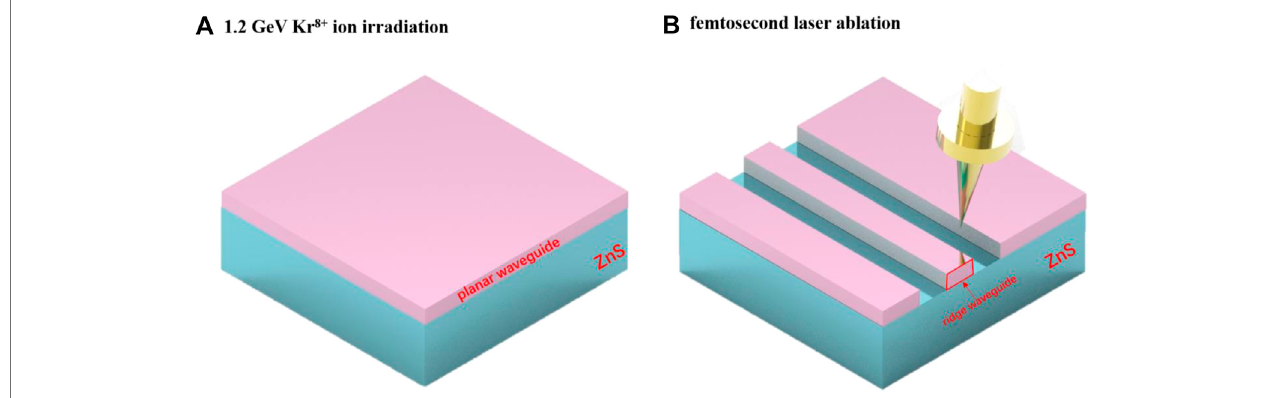
FIGURE 1 | Preparation of ZnS ridge waveguides. (A) 1.2 GeV Kr 8+ ion irradiation (B) femtosecond laser